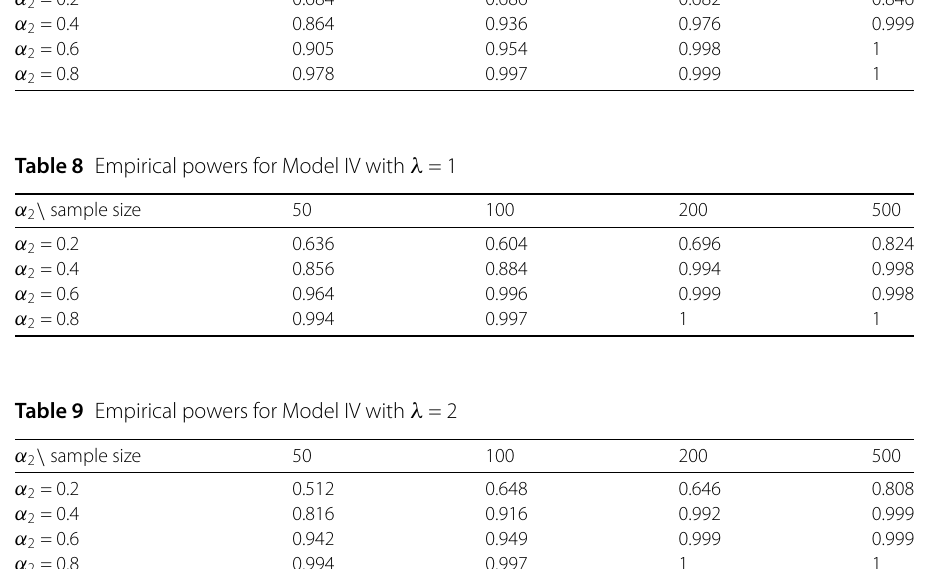
Table 7 Empirical powers for Model III with λ = 2 α 2 \ sample size 50 100 200 500 α 2 = 0.2 0.684 0.686